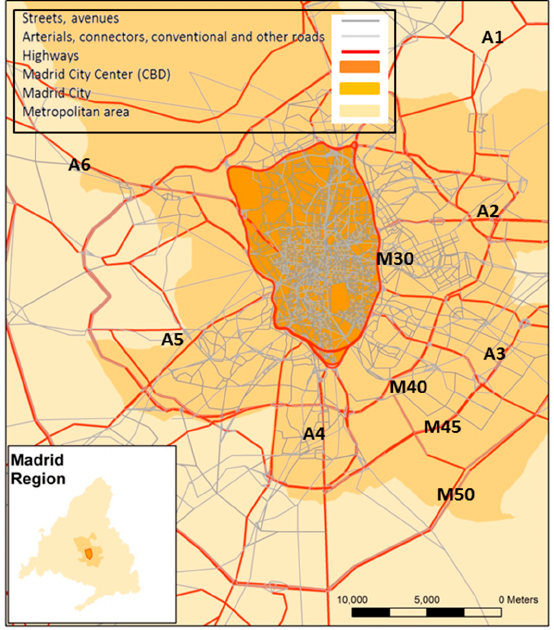
Figure 3. Madrid road network.